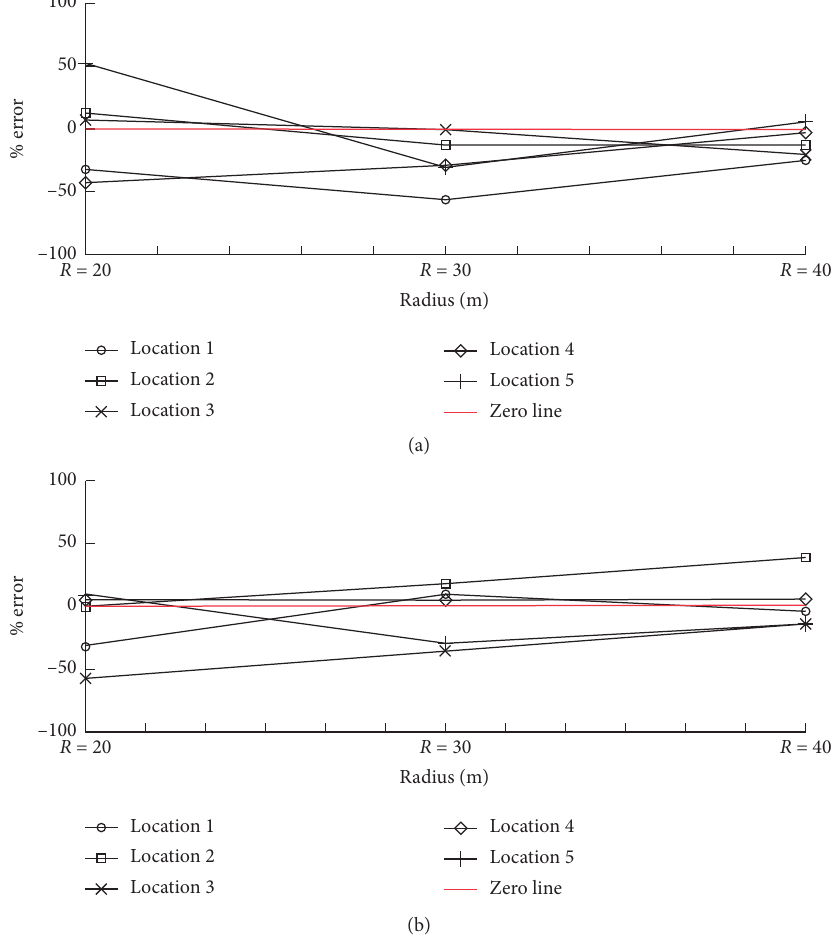
Figure 13: Prediction error of intensity associated with finite sample sizes and spatial variability based on Mauldon’s equation using circular windows of different sizes placed at different locations on the outcrop. (a) Set 1. (b) Set